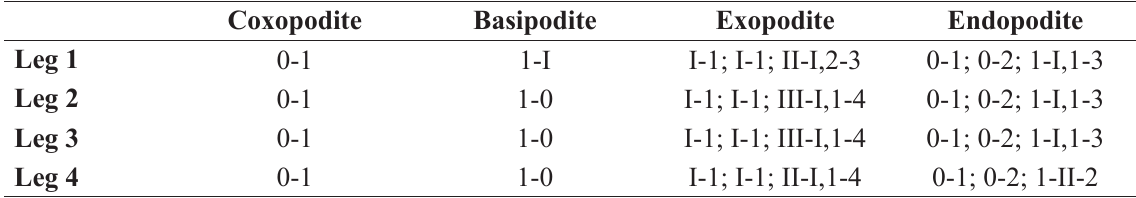
Table 2. Armature of legs 1−4 in Eucyclops azorensis Defaye & Dussart, 1991. Spines are denoted by Roman numerals, setae by Arabic numerals. The armature on the lateral margin of any segment is given first, followed by the elements on the apical and medial